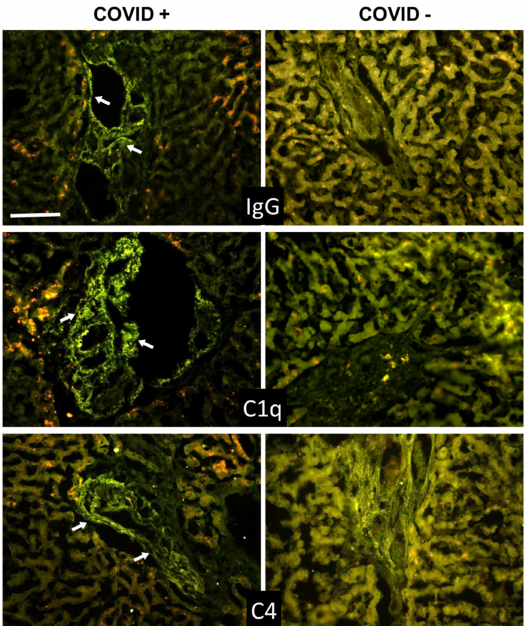
Figure 5. Detection of IgG, C1q, and C4 in liver sections by immunofluorescence analysis. The panel shows representative immunofluorescence images obtained from the analysis of several sections of liver autopsy samples from 12 SARS-CoV-2-positive and 3 SARS-CoV-2-negative cases. See legend to Figure 1 for further details. White arrows indicate vessels in the portal area. Scale bar = 50 µ m.